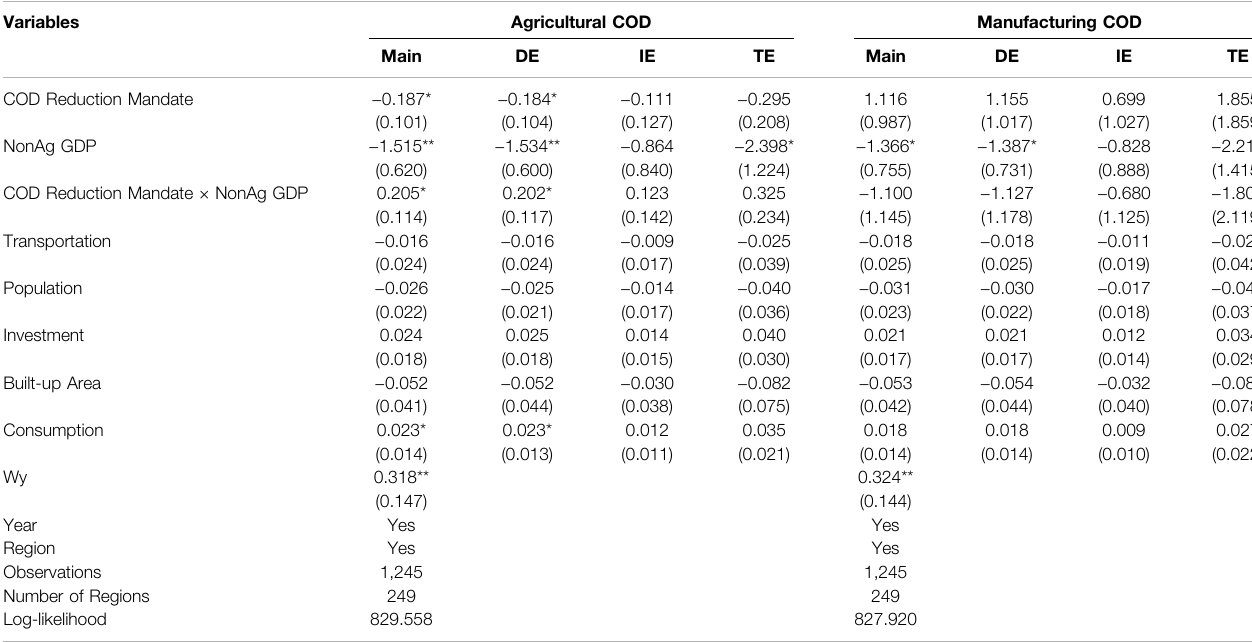
TABLE 7 | Robustness